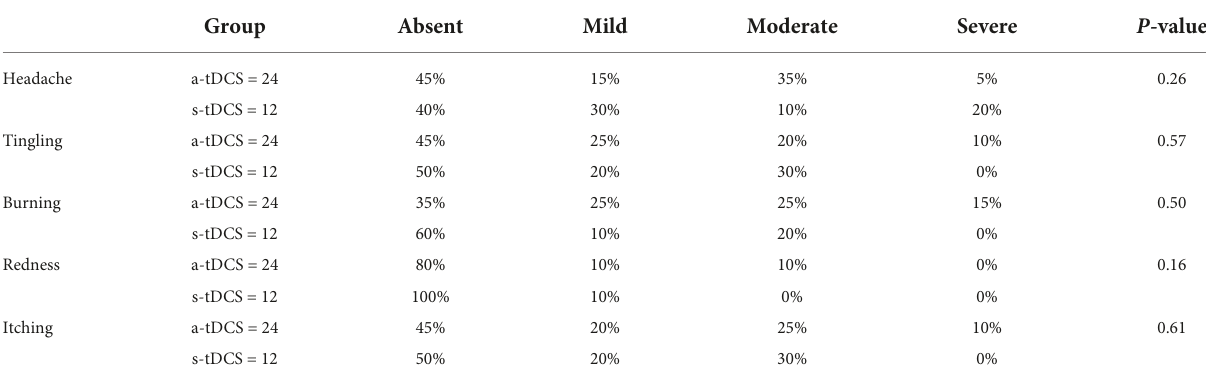
TABLE 5 Side effects are presented as percentage (%), and the incidence or severity of side effects classified as absent, mild, moderate, and severe ( n =